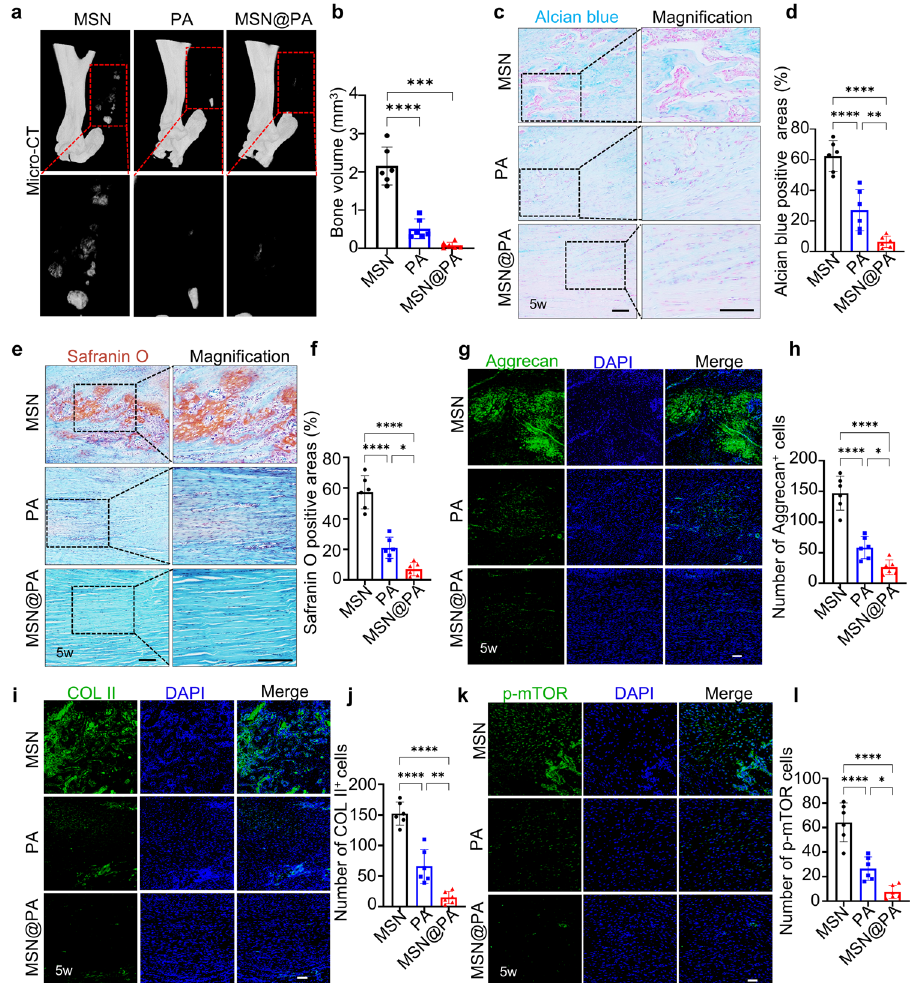
Fig. 6 MSN@PA better prevents heterotopic ossi fi cation by inhibiting activation of mTOR. a Micro-CT scans of repaired tendons from the PBS and PA groups at 5 weeks. b Semi-quanti fi cation of high-intensity zones in a . c Alcian blue staining of repaired tendons from the PBS and PA groups at 5 weeks. Scale bar, 100 μ m. d Semi-quanti fi cation of c . e Safranin O staining of repaired tendons from the PBS and PA groups at 5 weeks. Scale bar, 100 μ m. f Semi-quanti fi cation of e . g Immuno fl uorescence staining of chondrocyte marker Aggrecan in repaired tendons from the PBS and PA groups at 5 weeks. Scale bar, 100 μ m. h Semi-quanti fi cation of g . i Immuno fl uorescence staining of chondrocyte marker COL II in repaired tendons from the PBS and PA groups at 5 weeks. Scale bar, 100 μ m. j Semi-quanti fi cation of i . k Immuno fl uorescence staining of p-mTOR repaired tendons from the PBS and PA groups at 5 weeks. Scale bar, 100 μ m. l Semi-quanti fi cation of ( k ). Data are presented as mean ± SD. * p < 0.05, ** p < 0.01, *** p < 0.001 and **** p < 0.0001, n =